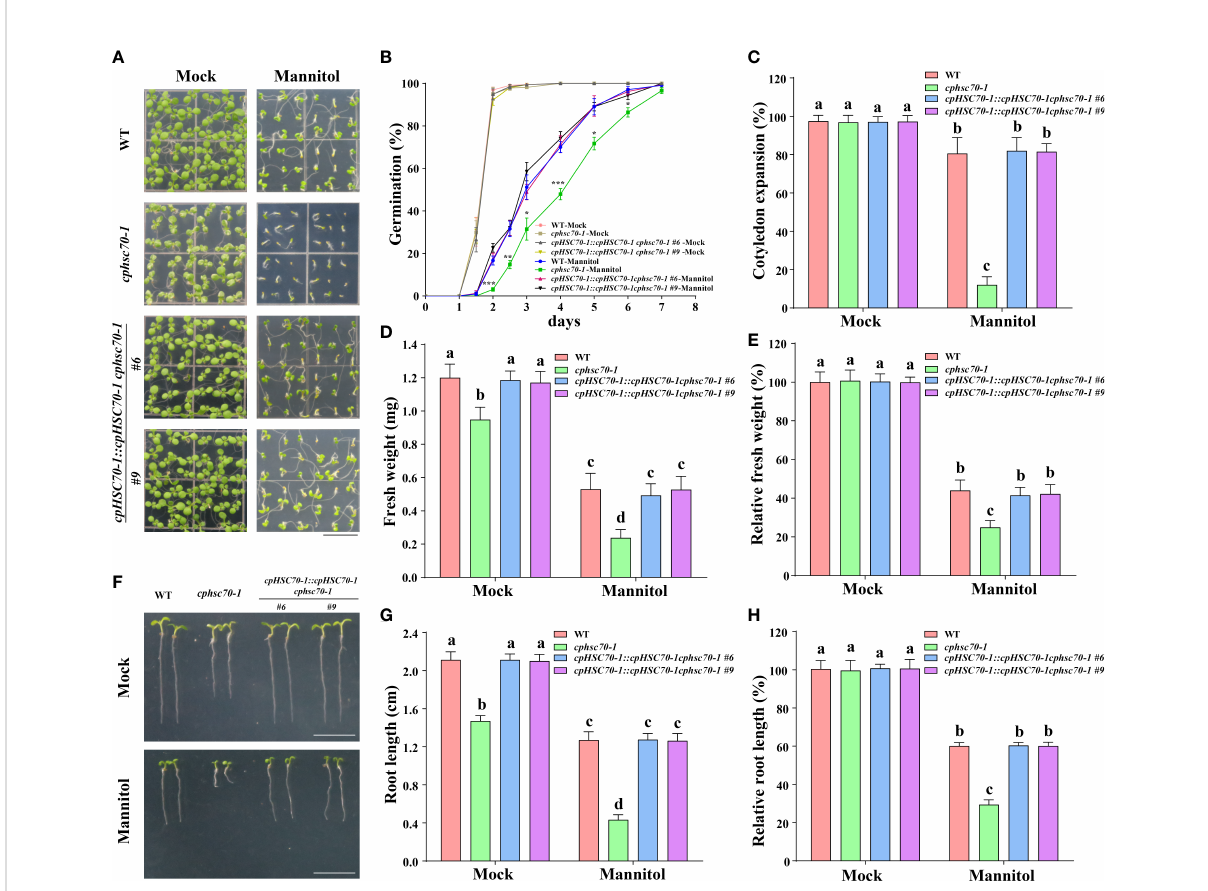
FIGURE 2 Loss-of-function mutation of cpHSC70-1 increases plant sensitivity to osmotic stress. (A) Images of 5-day-old wild-type, cphsc70-1 , and cpHSC70-1::cpHSC70-1 cphsc70-1 seedlings grown on 1/2 MS medium with or without (Mock) 300 mM mannitol. Bars = 1 cm. (B) Germination rate of the wild-type, cphsc70-1 , and cpHSC70-1::cpHSC70-1 cphsc70-1 plants in response to 300 mM mannitol. (C) Rate of cotyledon expansion, (D) fresh weight, and (E) relative fresh weight of the wild-type, cphsc70-1 , and cpHSC70-1::cpHSC70-1 cphsc70-1 plants in panel (A) . (F) Images of 5-day-old wild-type, cphsc70-1 , and cpHSC70-1::cpHSC70-1 cphsc70-1 seedlings grown on 1/2 MS medium with or without (Mock) 300 mM mannitol. Bars = 1 cm. (G) Root length and (H) relative root length of the plants shown in (F) . The data are means ( ± SD) from at least three independent experiments (n ≥ 60 for germination rate and n ≥ 30 for root length). Asterisks indicate signi fi cant differences revealed using a Student ’ s t -test (* p < 0.05; ** p < 0.01; *** p < 0.001). Different letters indicate signi fi cant differences as determined using ANOVA followed by Tukey ’ s test ( P <